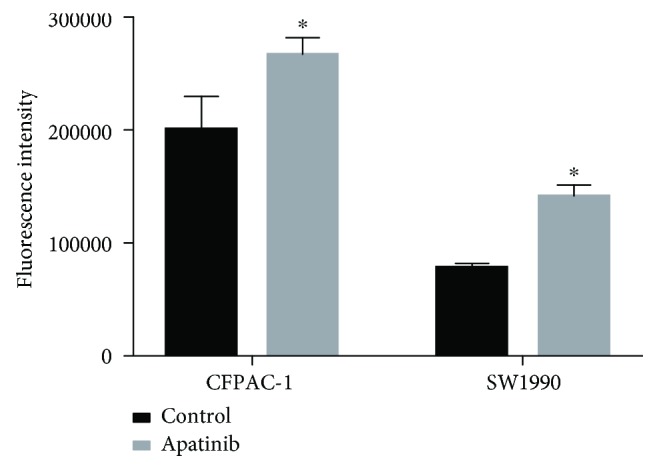
Apatinib induced apoptosis through an elevation of the levels of ROS. After treatment for 24 h, CFPAC-1 and SW1900 cells were stained using DCFH-DA. The fluorescence intensities of apatinib-treated and control cells are shown. All experiments were performed in triplicate. The bars represent mean ± standard deviation; ∗P < 0.05.